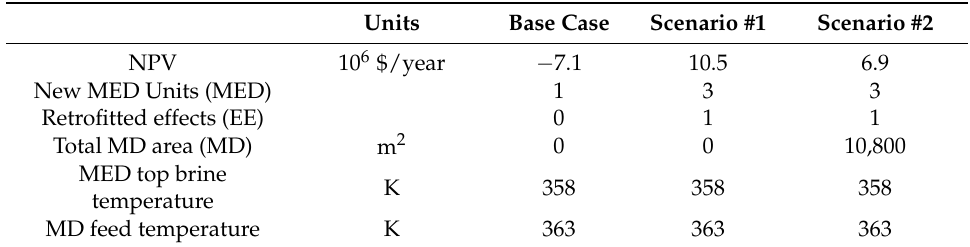
Table 2. Summary of results for the case